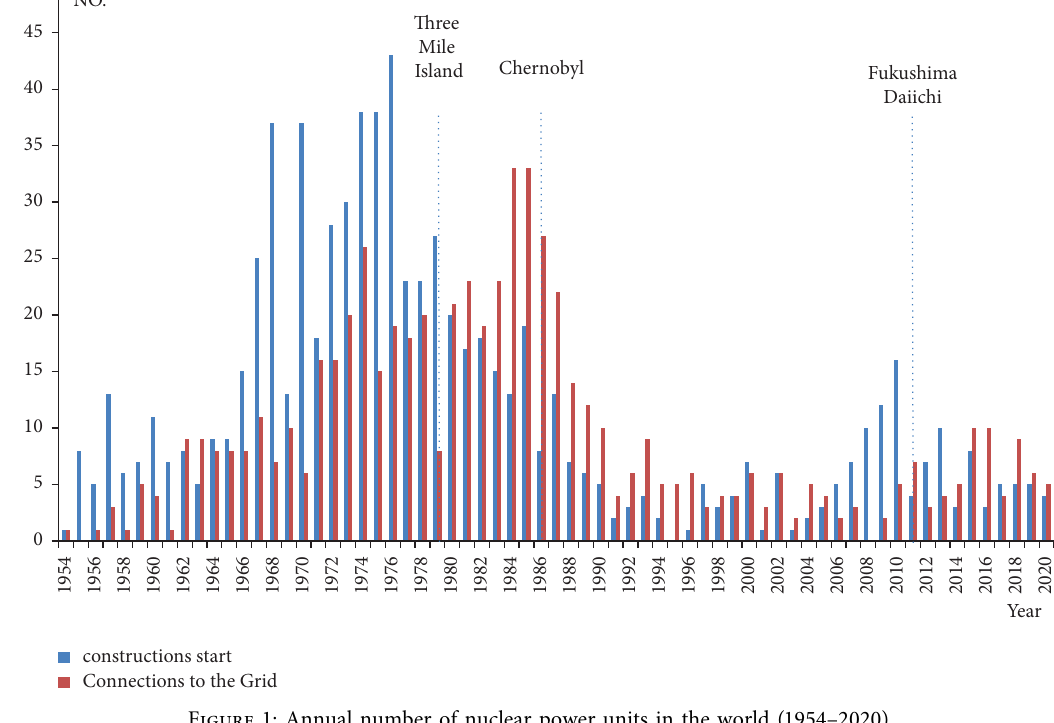
Figure 1: Annual number of nuclear power units in the world (1954–2020).